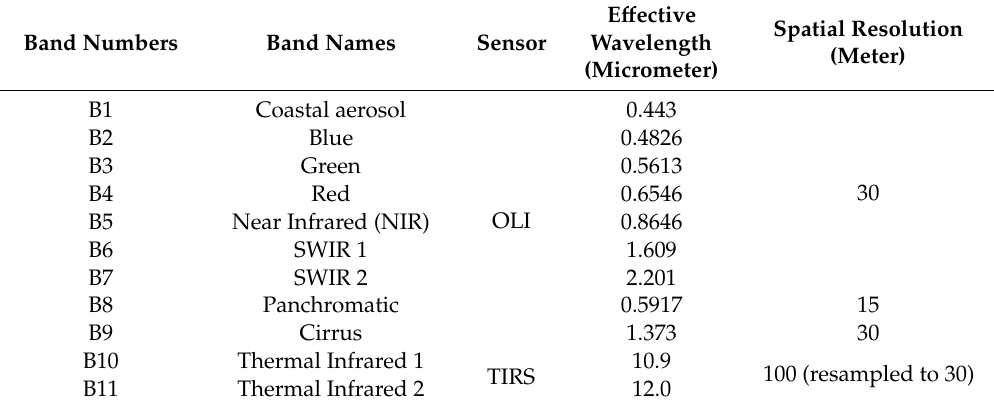
Table 3. Spectral and spatial characteristics of Landsat 8